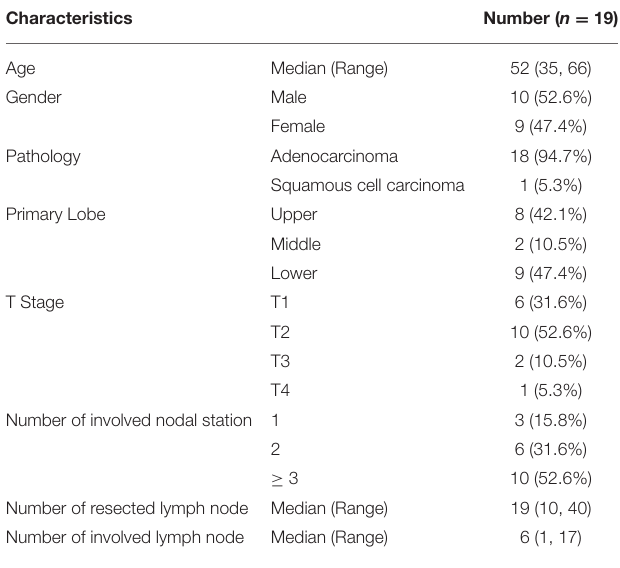
TABLE 1 | General characteristics of study